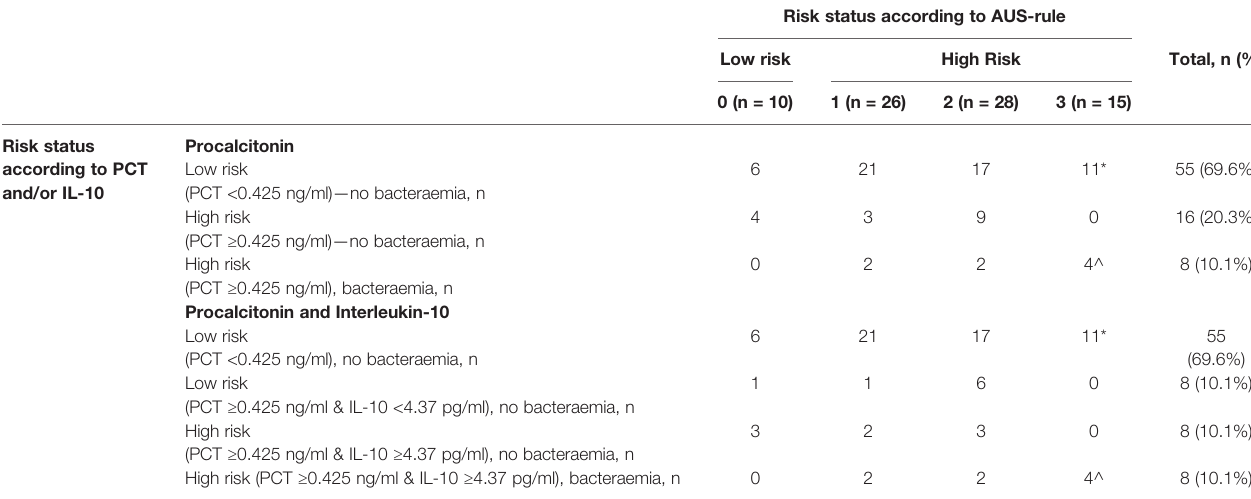
TABLE 4 | Combined performance of AUS-rule and PCT and IL-10 for prediction of bacteraemia episodes in children with febrile neutropenia (shaded area are episodes classi fi ed as